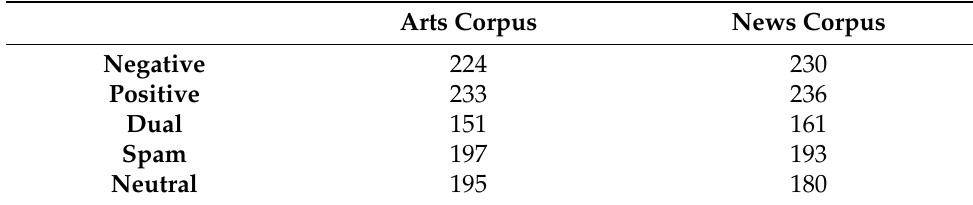
Table 2. Distribution of Posts in the